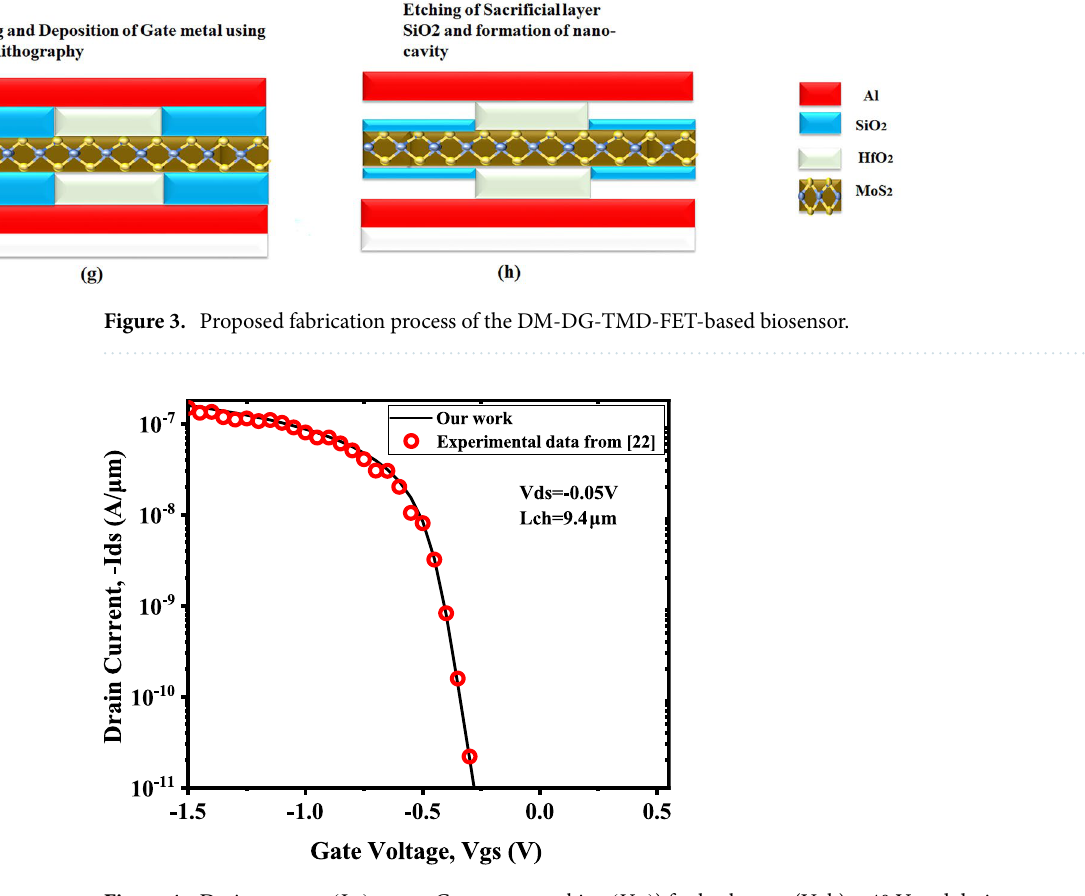
Figure 4. Drain current, ( I ds ) versus Gate to source bias, ( V gs ) ) for back-gate, (Vgb) − 40 V and drain to source bias, V ds = − 0.05 V with channel-length, L ch = 9.4 nm, front and back gate oxides are ZrO 2 T tox = 17.5 nm , k tox = 12.5 and SiO 2 ( T box = 270 nm, k box = 3.9 )